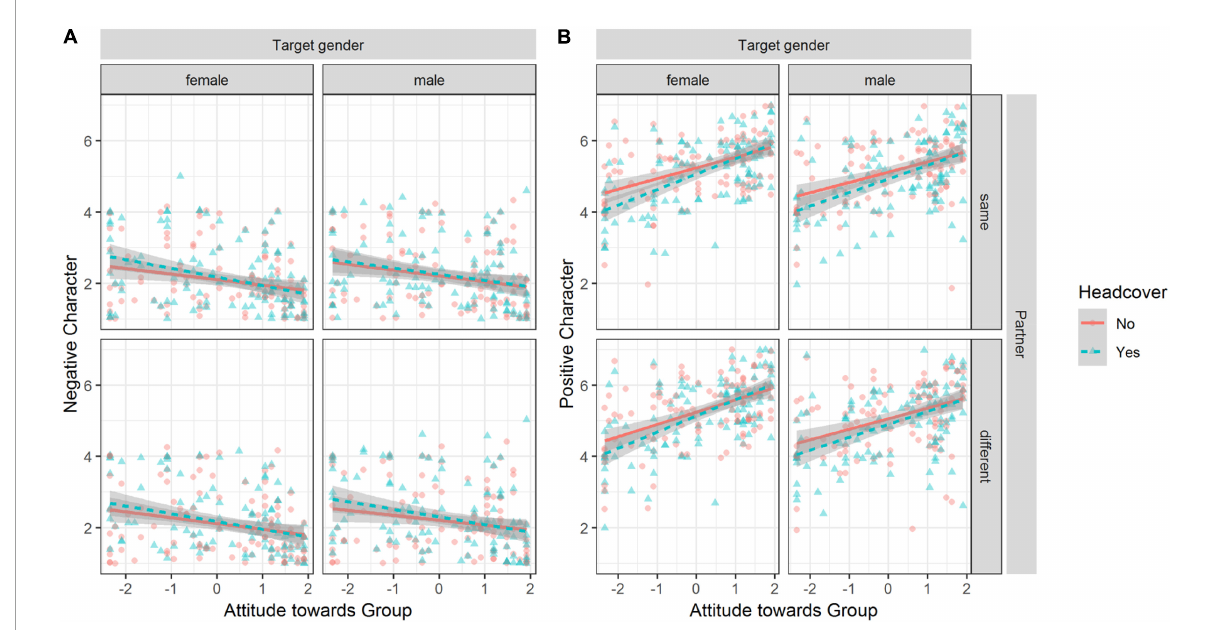
FIGURE8 Observed positive and negative character judgments dependent on attitude, head cover, target person gender, and partner. Plot (A) for negative character judgments. Plot (B) for positive character judgments. Lines depict linear regression of Y on X; the shaded areas show the 95% CI of the estimate. Points are jittered to avoid